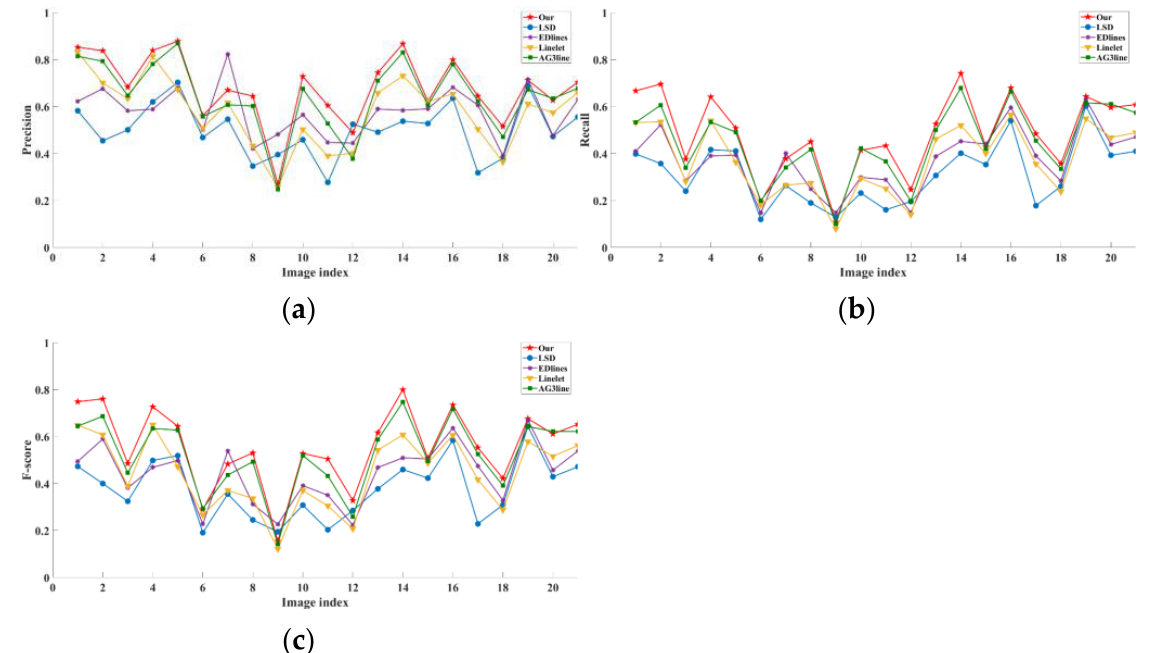
Figure 11. Detailed performance of different methods on the MNS-LS dataset. ( a ) Precision. ( b ) Recall. ( c ) F-score.